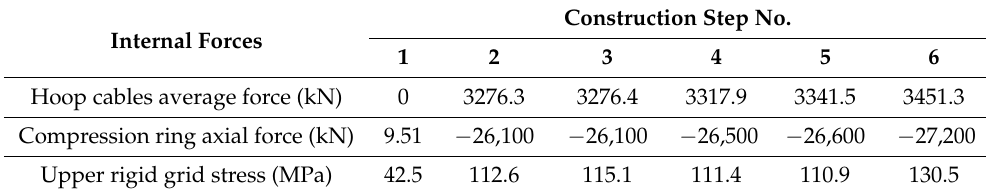
Table 5. Internal forces during the construction process.